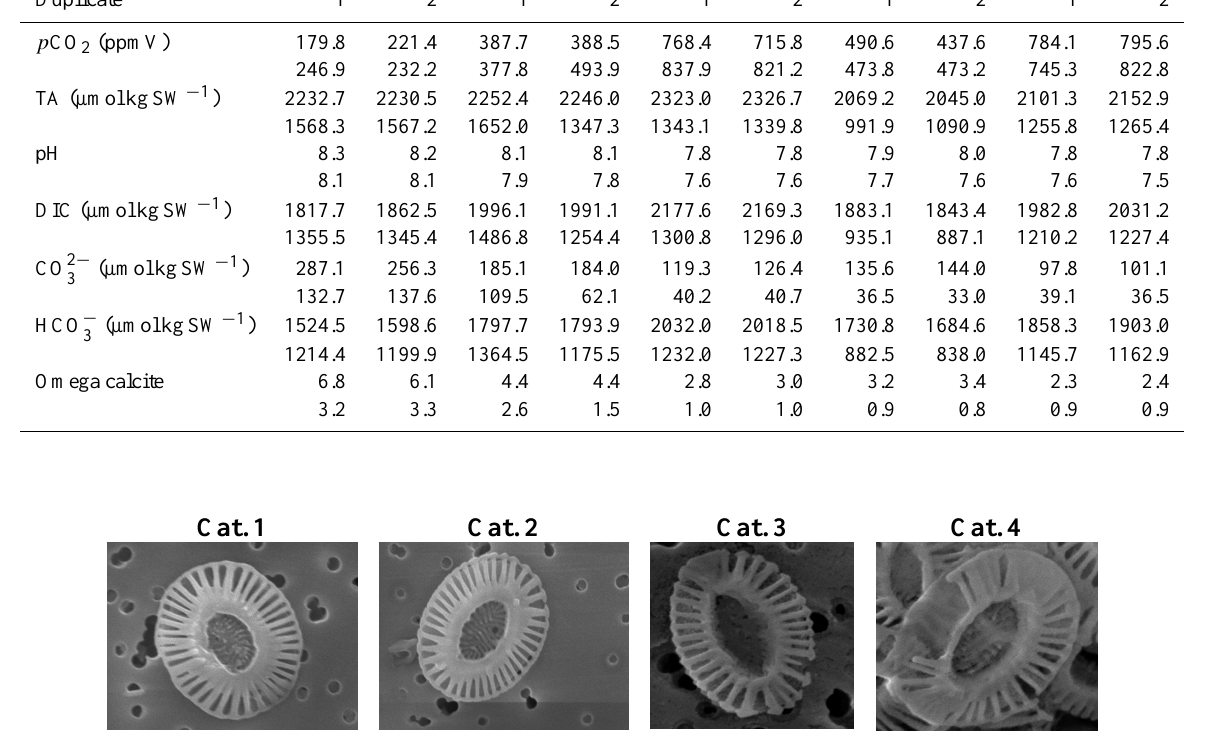
d 36 and d 40 for future CO 2 treatments and between d 45 and d 52 for the experiments at present and low CO 2 (data not shown). Maximum cell densities varied from 2.22 × 10 5 to 3.84 × 10 5 cells ml − 1 among batch cultures with highest val- ues reached in the future CO 2 cultures (Table 2). At 18 ◦ C, maximum cell density was reached between d 34 and d 40 de- pending on the experiment (data not shown). In the fu-